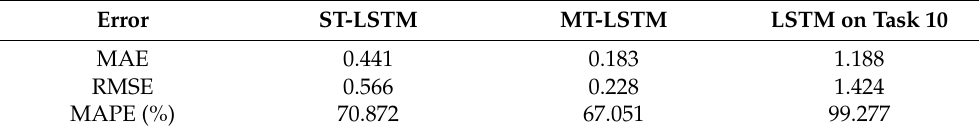
Figure 16. Prediction results of MT-LSTM, ST-MTGP, and LSTM for the extreme situation (with data pre-processing). Table 10. Error results of STGP and MTGP (with data pre-processing). Table 11. Error results of MT-LSTM, ST-LSTM, and LSTM (with data pre-processing).